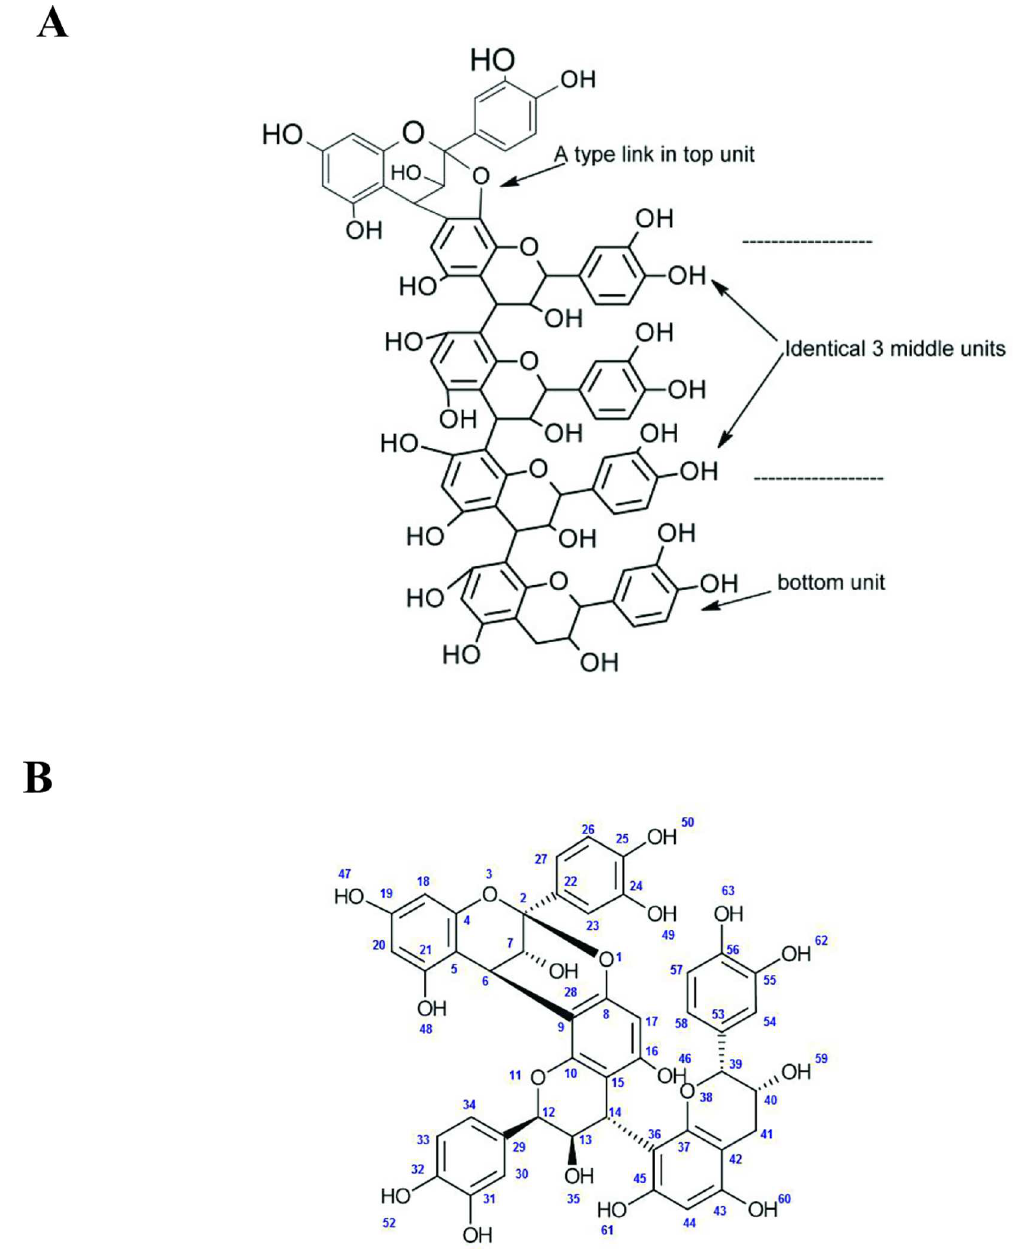
Fig 1. Structure of IND02. Structure of the IND02 compounds, isolated from cinnamonand characterized as pentameric(A) or trimeric (B) procyanidin A (see HPLC analyses in Figures A and B in S1